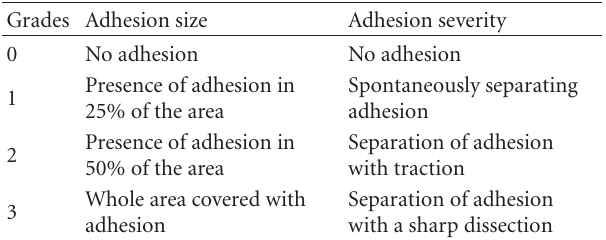
Ecza Co.), flax seed oil (Keten yagi, Arifoglu Co.), aloe